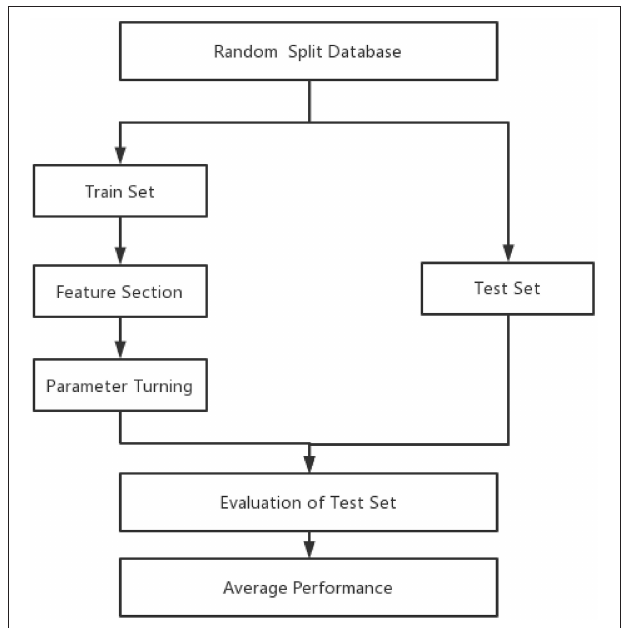
FIGURE 1 | Forest plot of predictors for